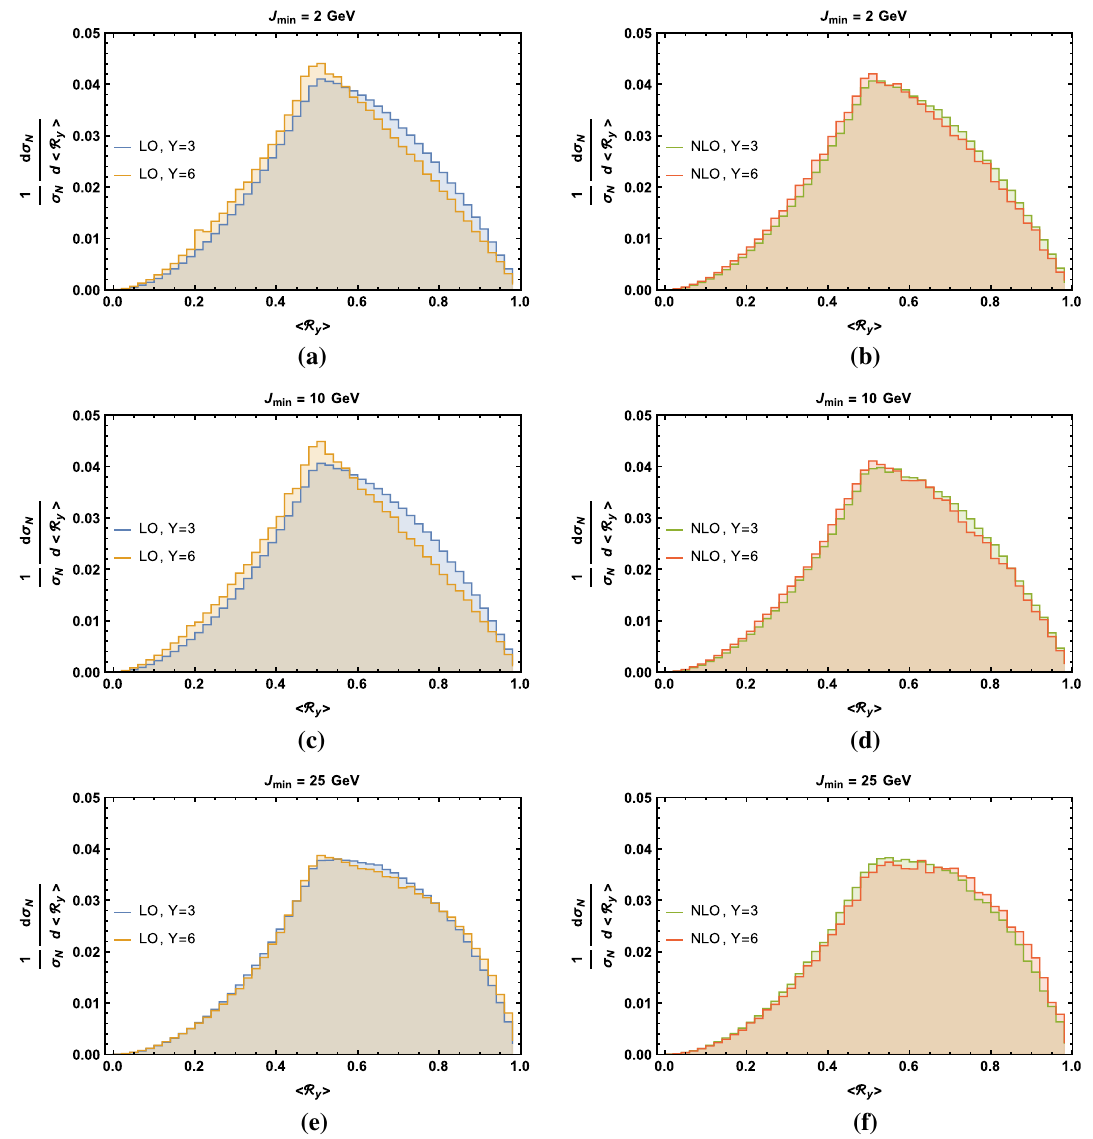
Fig. 2 Normalized (cid:10) R y (cid:11) at LO (left) and NLO+DLs (right) for multiplicity N = 3, rapidity difference Y = 3 , 6 and J min = 2 (top), J min = 10 (middle), J min = 25